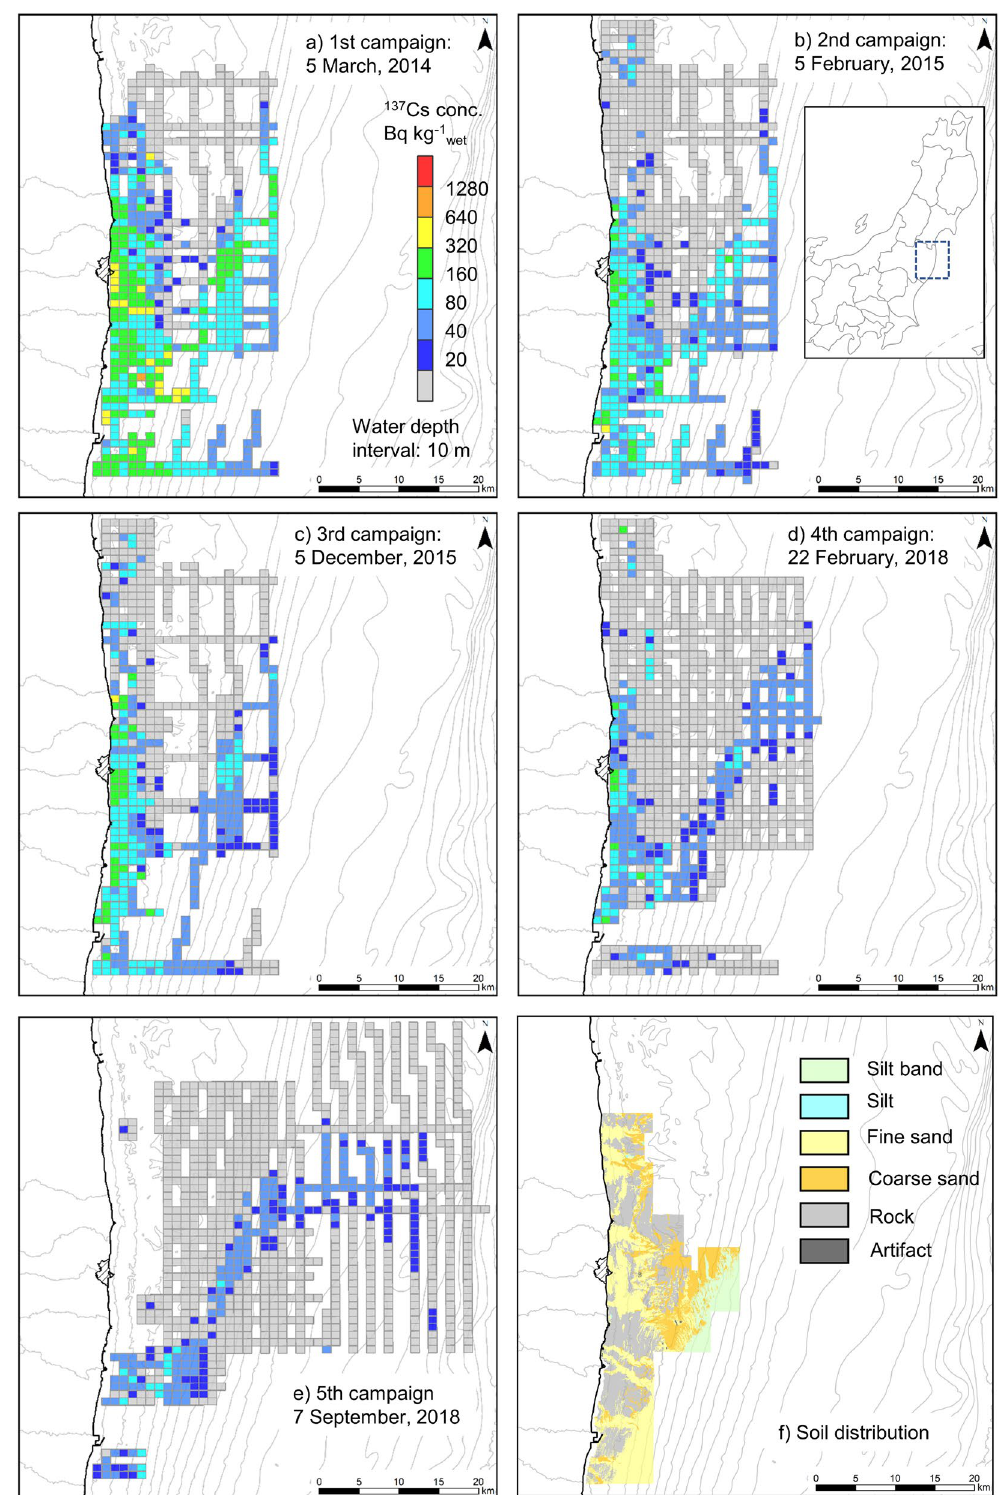
Figure 2. Contour maps of 137 Cs distribution by mesh averaging method. ( a – e ): 137 Cs distribution by towed radiation survey and ( f ) sediment distribution map by a bathymetric survey and sonic prospecting. Map created with ESRI ArcGIS 10.7.1. Basemap sources: M7000 Digital Bathymetric Chart (Shapefile) published by Marine Information Research